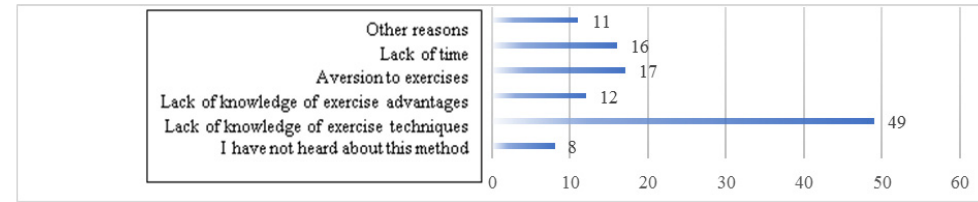
Figure 1. Reasons for not doing pelvic floor muscle exercises.